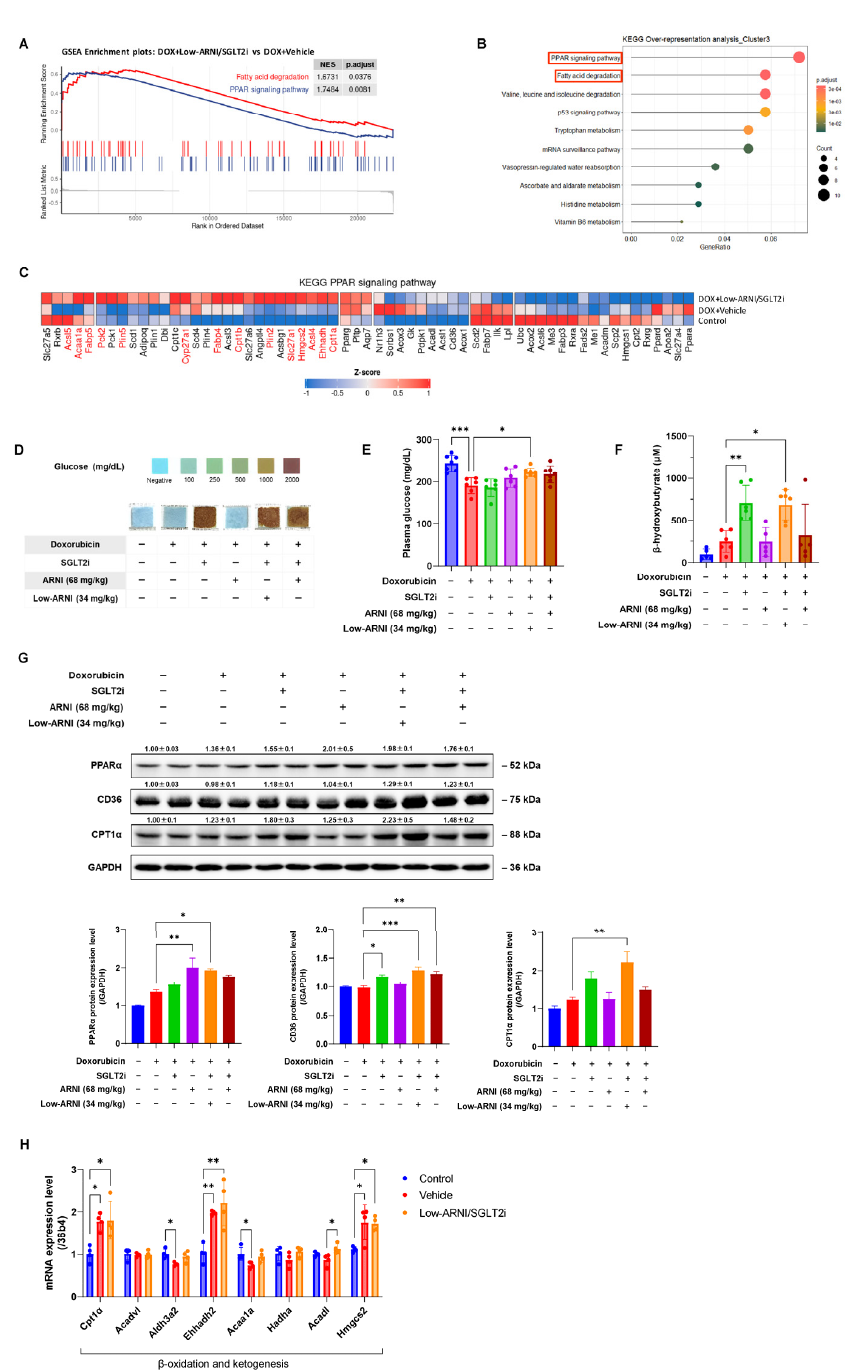
Figure 5. Effects of ARNI and SGLT2i treatment on cardiac energy metabolism in doxorubicin- induced cardiac injury. ( A ) GSEA plots associated with Low-ARNI/SGLT2i-treated groups. ( B ) Sum- mary plot for over-representation analysis with Kyoto Encyclopedia of Genes and Genomes pathway of cluster 3 in hierarchical clustering. ( C ) Heat maps of relative mRNA expression of indicated genes in PPAR signaling pathway from control, doxorubicin + vehicle, and doxorubicin + Low- ARNI/SGLT2i groups. ( D ) Urine glucose, ( E ) plasma glucose and ( F ) plasma β -hydroxybutyrate levels ( n = 5–7 per group). ( G ) Representative immunoblots of PPAR α , CD36, and CPT1 α protein at 9 weeks after doxorubicin injection in indicated experimental groups and graphical quantification ( n = 4–5 per group) ( H ) mRNA levels of β -oxidation and ketogenesis-related genes are determined by qRT-PCR ( n = 4 per group). * p < 0.05, ** p < 0.01, *** p <